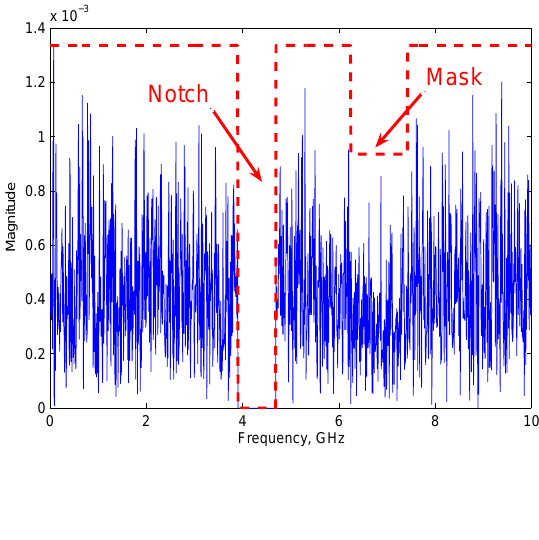
Figure 28. Spectrum Mask of the transmitted signal. The ’notch’ part is set to cancel the interference at the receiver. Transmitter also has the ’notch’ part because CS requires consis- tency at the receiver and transmitter. The ’mask’ part is set to avoid interfering primary